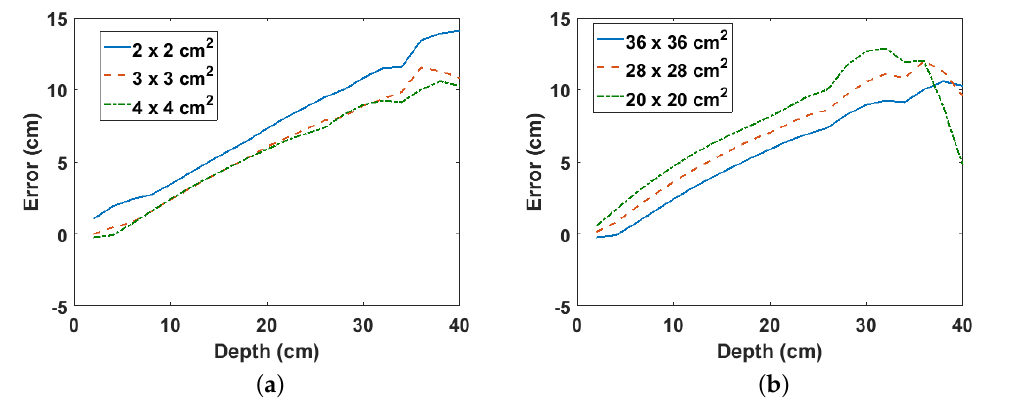
Figure 7. ( a ) Error per depth for different cell sizes for Cs-137 buried in sand; ( b ) error per depth for different scan areas for Cs-137 buried in sand.